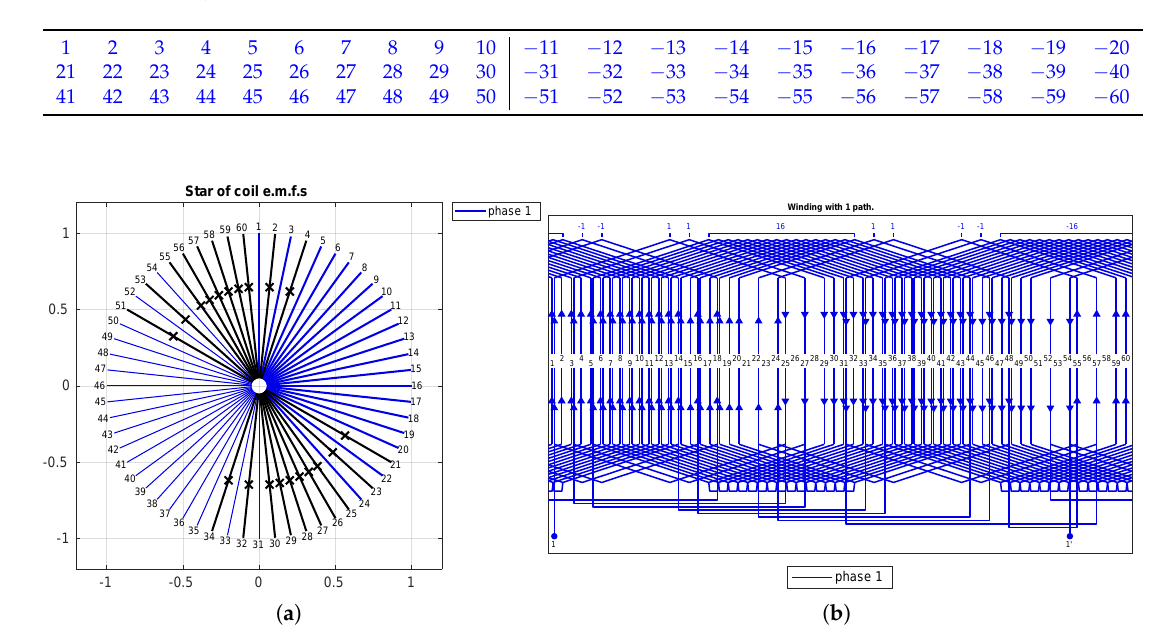
Table 21. WDT with a double chording and a 3-rd order double-sided imbrication for N = 60, p = 1, m = 1 and q = 30.